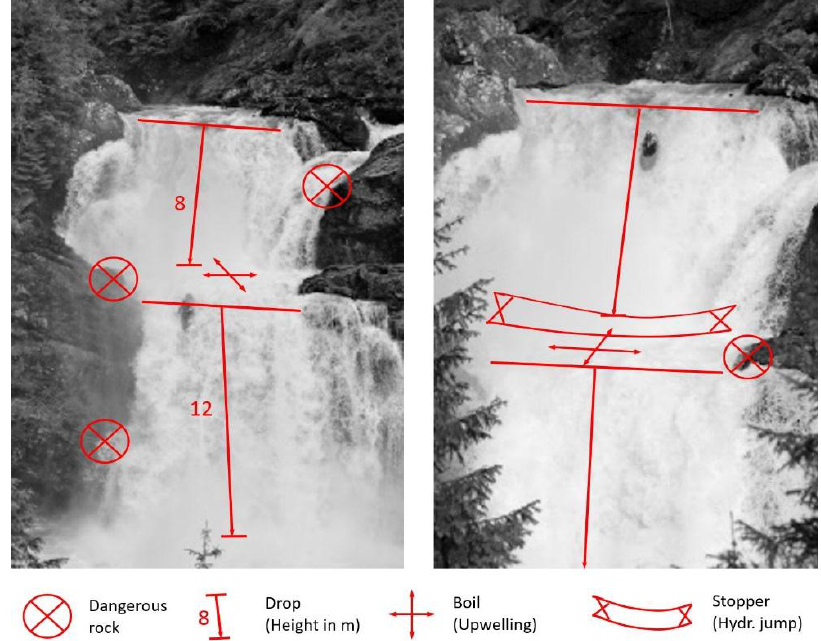
Figure 12. Double drop with kayaking activities during high flows. The left situation is suitable for many skilled kayakers, while the flow conditions on the right photo can only be managed by few world class experts. Photos: Steve Arns ( left ) and Benjamin Hjort ( right ).